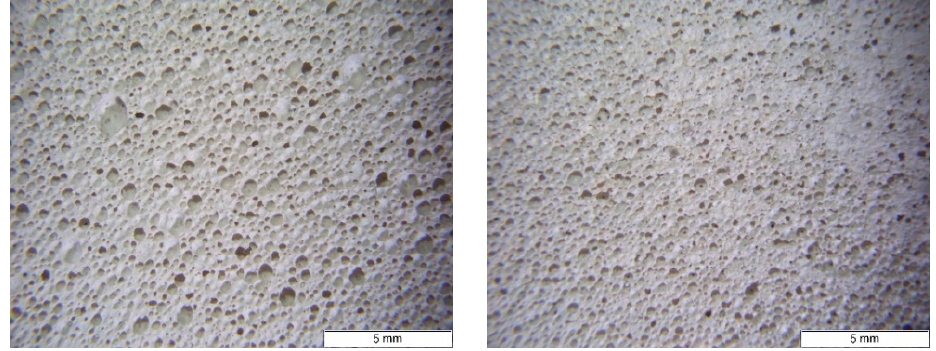
Figure 6. Light microscopic images of foamed concrete: control mix, C ( left ), C/FA ( right ).